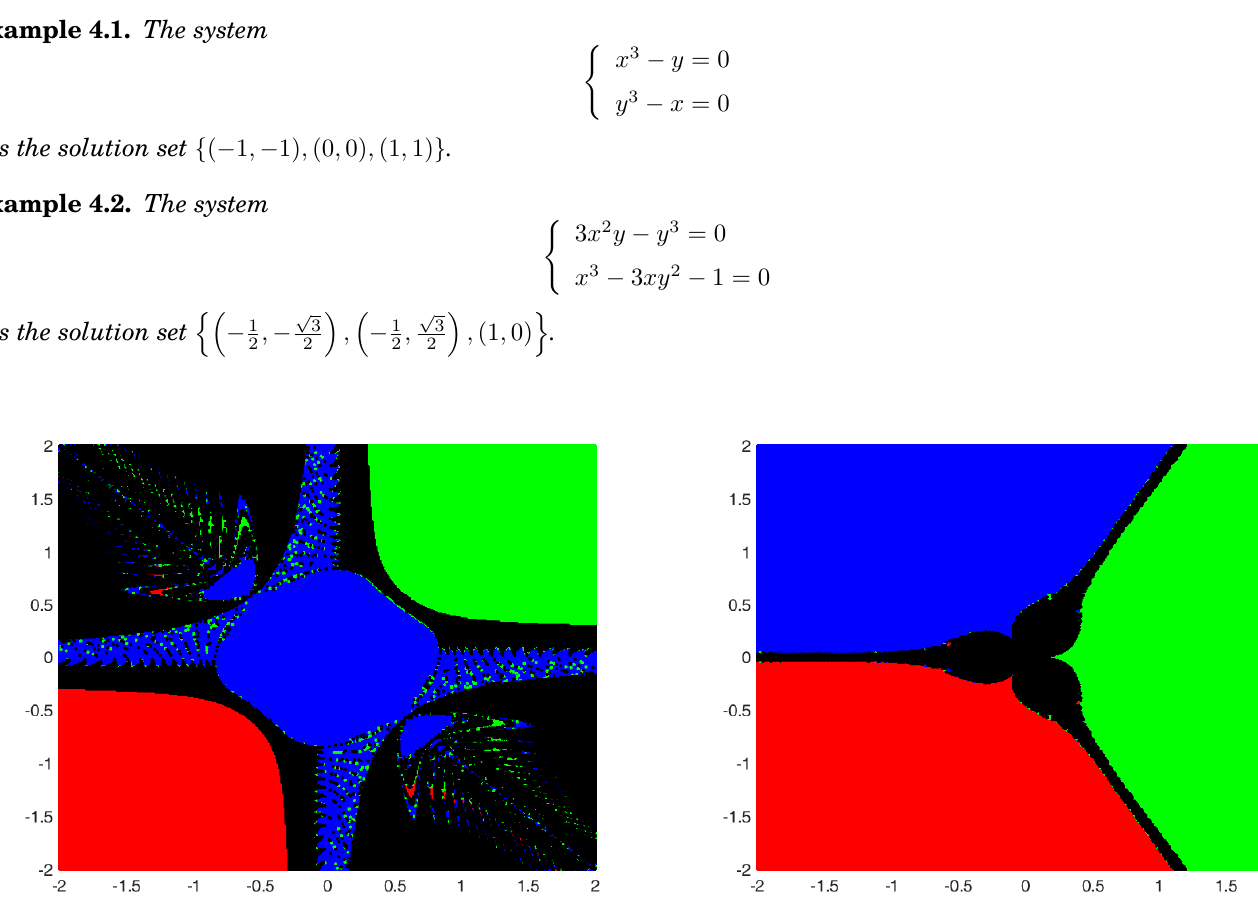
Figure 1: Dynamical plane of Method (1) with basins of attraction for Examples 4.1 and